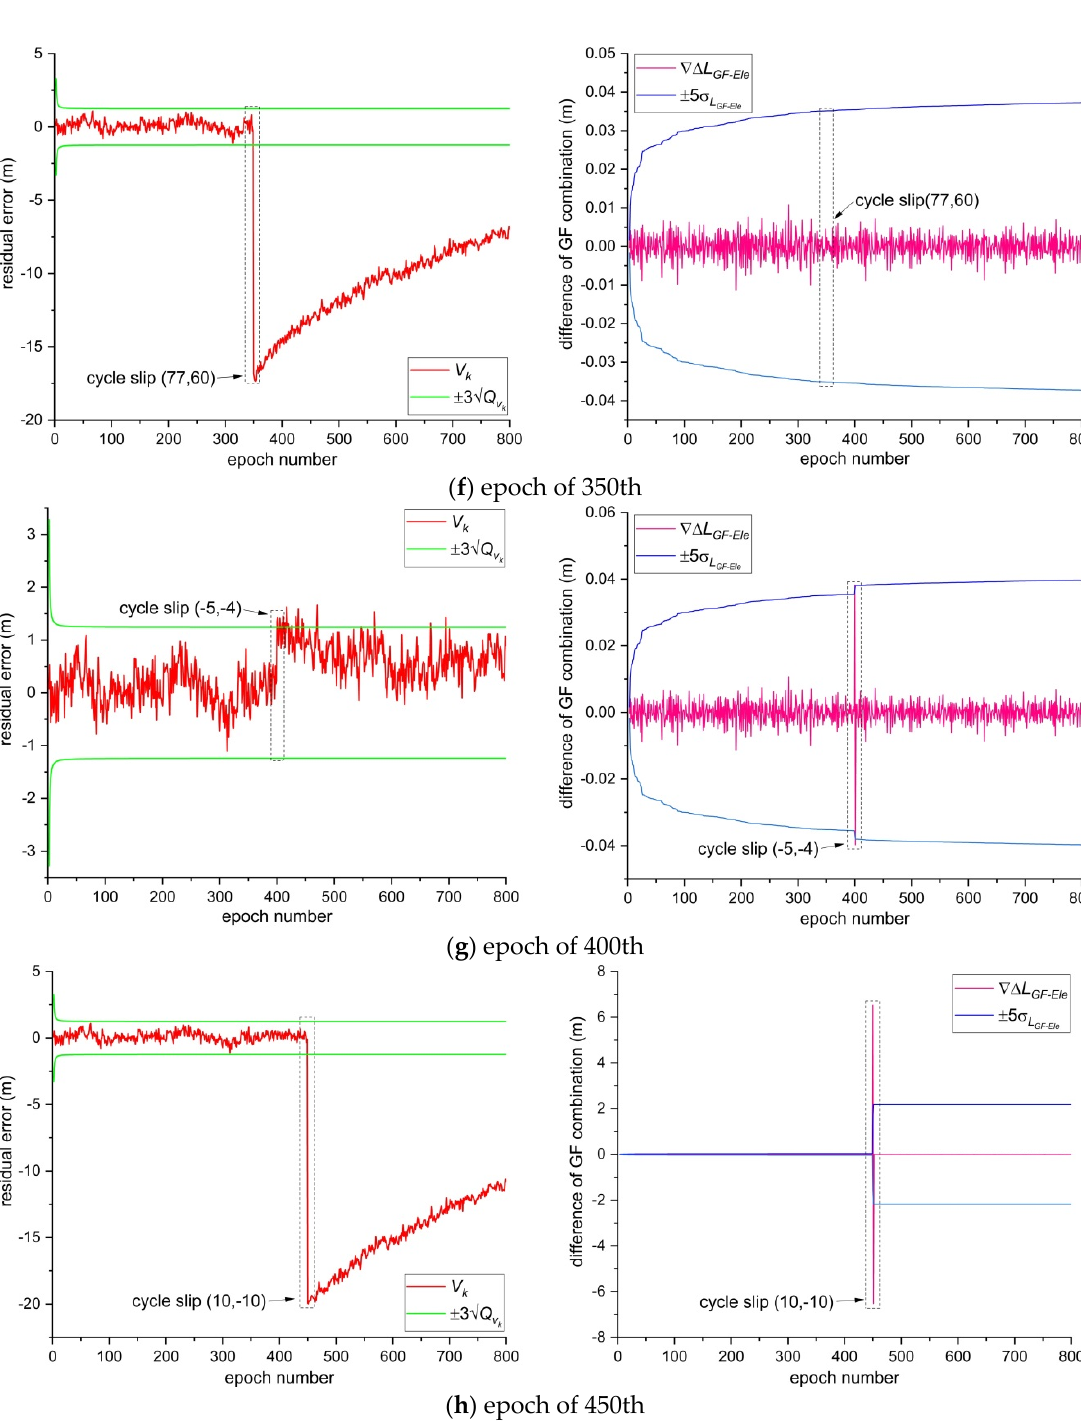
Figure 10. Cycle slip detection results of satellite G03 at different epochs under high-voltage transmission line environ- ment.